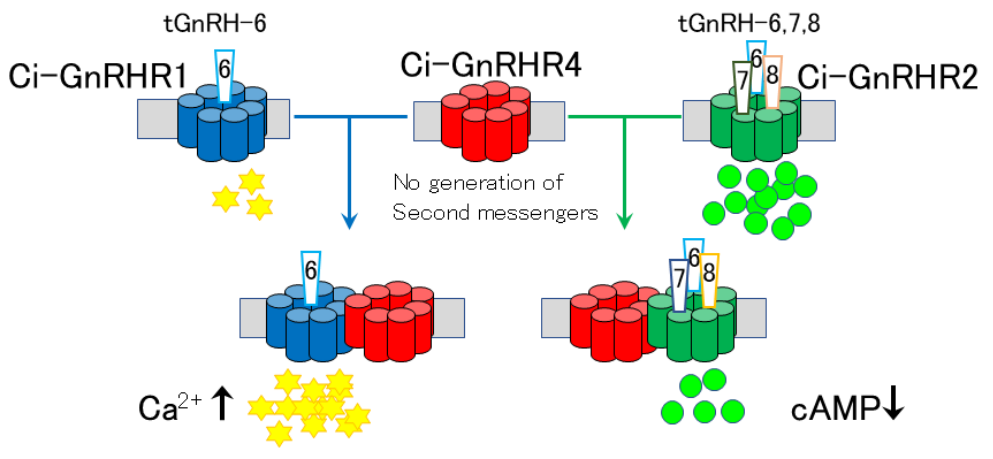
Figure 2. Differential regulation of GnRH signaling pathways via GPCR heterodimerization. Heterodimerization between Ci-GnRHR-1 and -4 results in a 10-fold more potent intracellular calcium ion mobilization response to tGnRH-6 compared with the Ci-GnRHR-1 monomer / homodimer. Heterodimerization between Ci-GnRHR-2 and -4 decreases cAMP production by 50% in response to tGnRH-6, 7, and 8 compared with the Ci-GnRHR-1 monomer/homodimer.